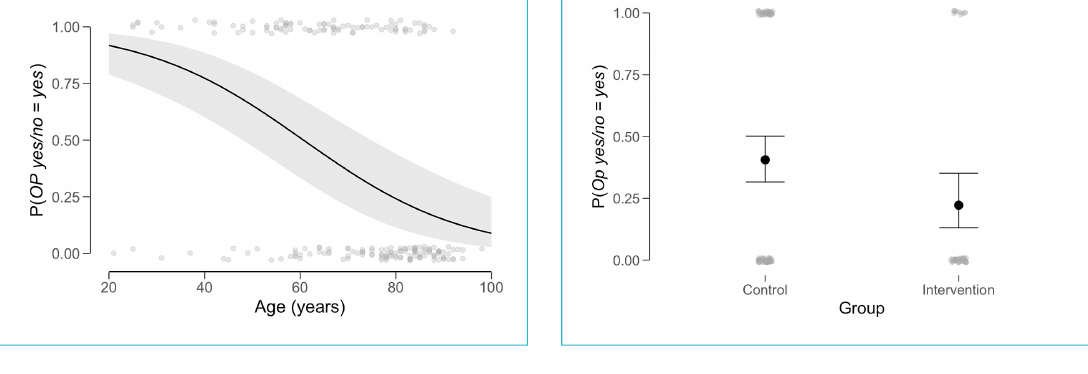
Figure 5: Correlation between age and operation likelihood.Op: Operation, Yes(1): Patients who underwent surgery after primarily being treated conservatively, No(0): completely conservatively treated patients, P: likelihood, grey dots: every dot represents one patient. Grey banner: 95% confidence interval, black line: opera- tion likelihood according to patient’s age.